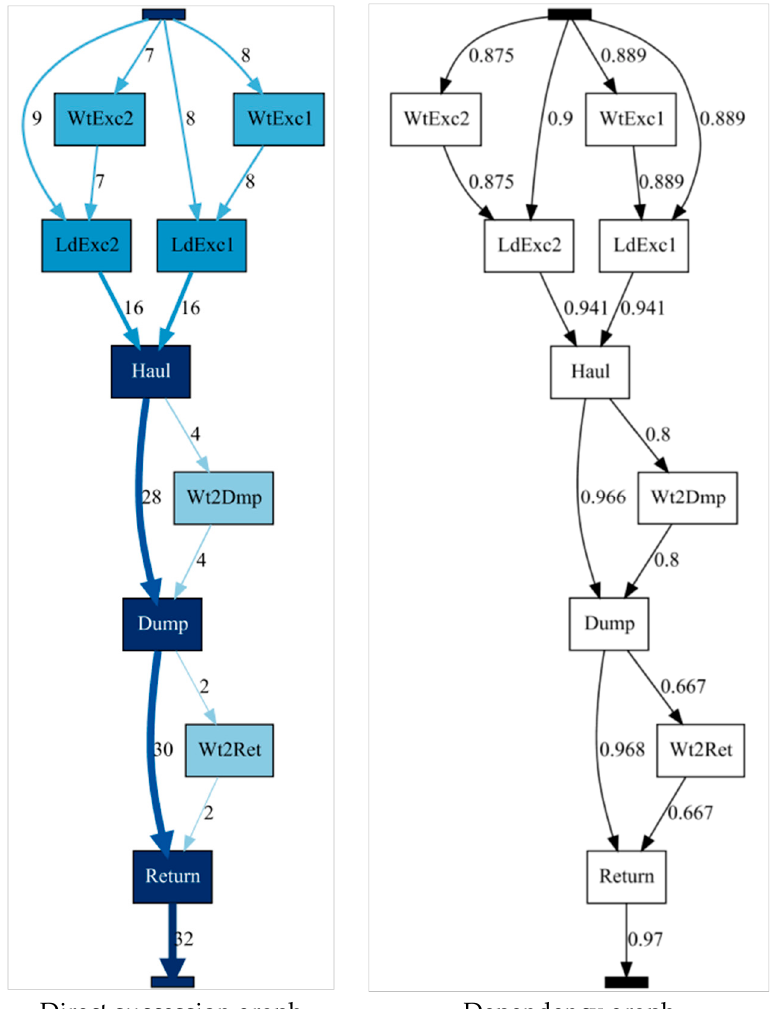
Figure 10. Process discovery using heuristic miner.